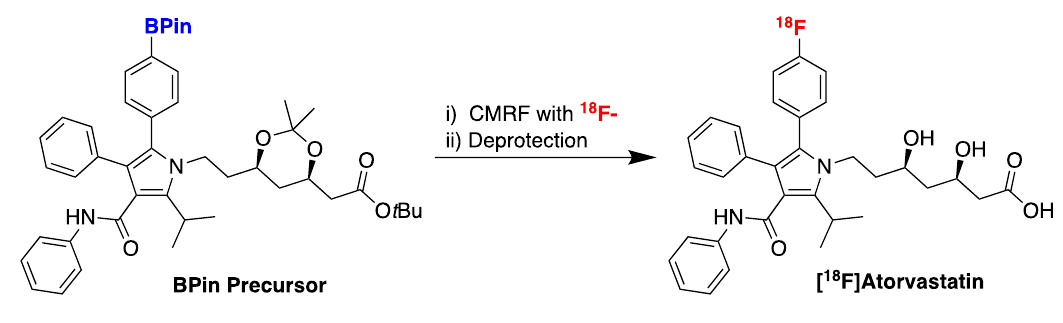
Figure 9. Radiosynthesis of [ 18 F]atorvastatin.